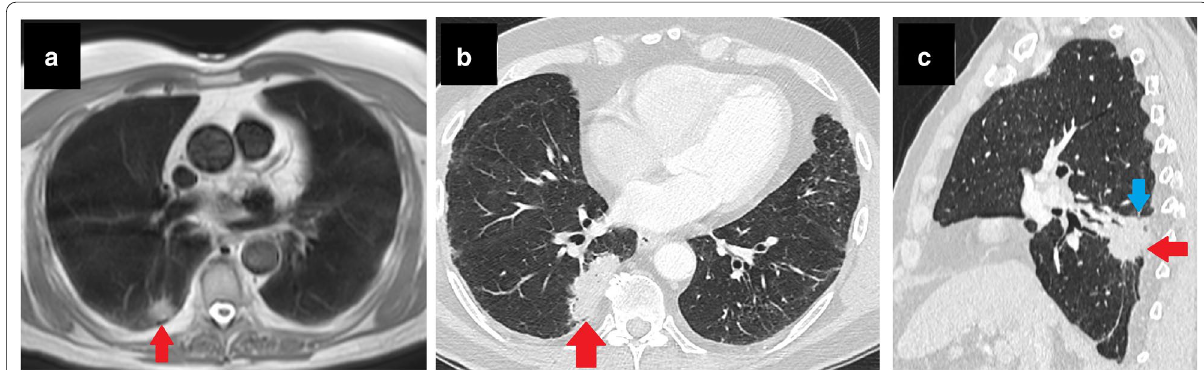
Fig. 23 Delay in diagnosis with indirect harm. Cardiac MRI of a 71-year-old male patient for evaluation of angina and left ventricle hypertrophy had shown a hyperintense lesion in the right lung, which had been seen in only one slice of black blood sequence with 8 mm slice thickness (red arrow, a ). This lesion had been overlooked due to the framing of clinical information and its location. A growing lung mass was detected three years later in the superior segment of the right lower lobe (red arrows, b , c ) on thorax CT. Percutaneous biopsy and subsequent histopathological examination confirmed primary lung cancer. Due to the major fissure invasion developed during the interval period (blue arrow, c ), the patient underwent right pneumonectomy instead of lobectomy